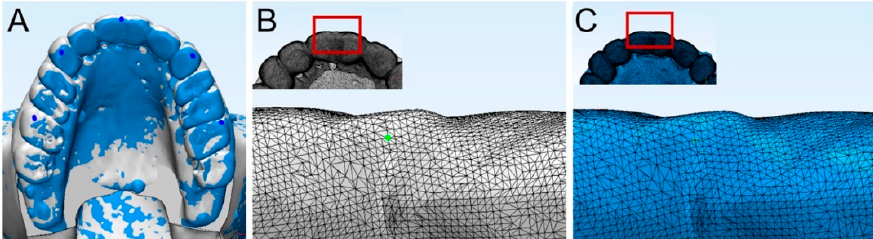
Figure 7. Comparison of the virtual surgical outcome and postoperative skull models. ( A ) After superimposition of the two models based on the local-best fit method; ( B ) selection of the landmark in the virtual surgical outcome using triangular nodes on the surface of teeth; ( C ) selection of the same landmark on the postoperative model using triangular nodes.